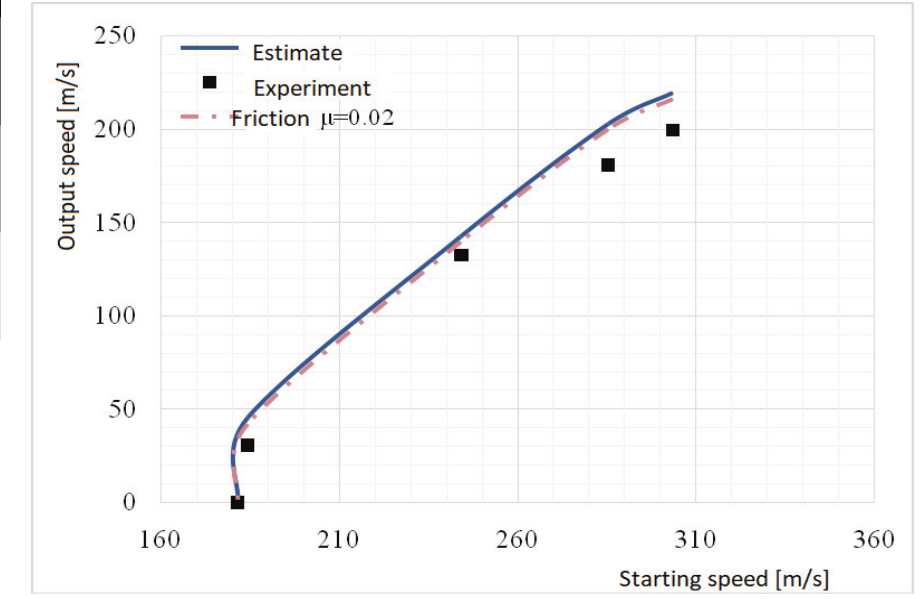
Figure 15 – FEM analysis by a blunt projectile for a plate of 12 mm thickness Рис . 15 – Анализ F Е M тупоконечным снарядом на плиту , толщиной 12 мм Слика 15 – Анализа ФЕМ тупим пројектилом за плочу дебљине 12